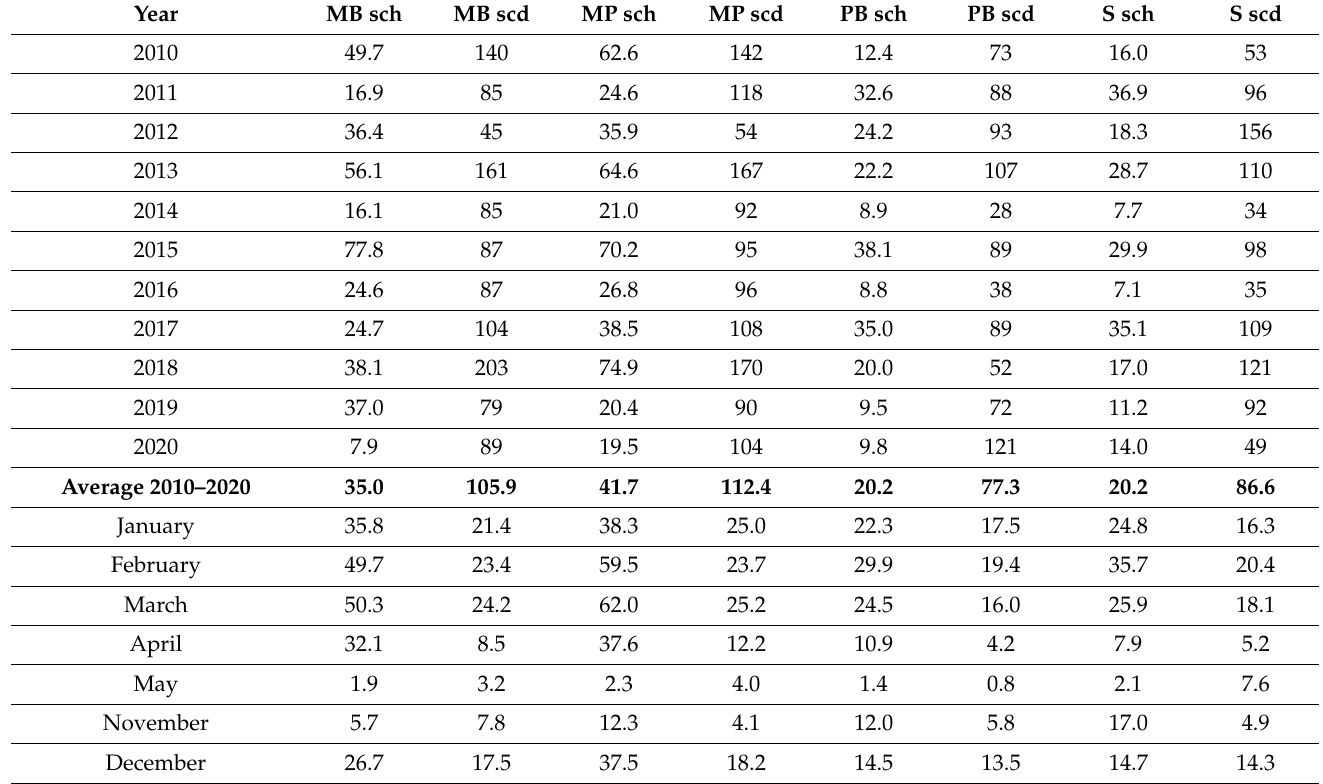
Table 2. Average daily snow cover height (sch) and days with snow cover (scd) in the following months: November, December, January, February, March, April, and May at each weather station (MB, MP, PB, S).